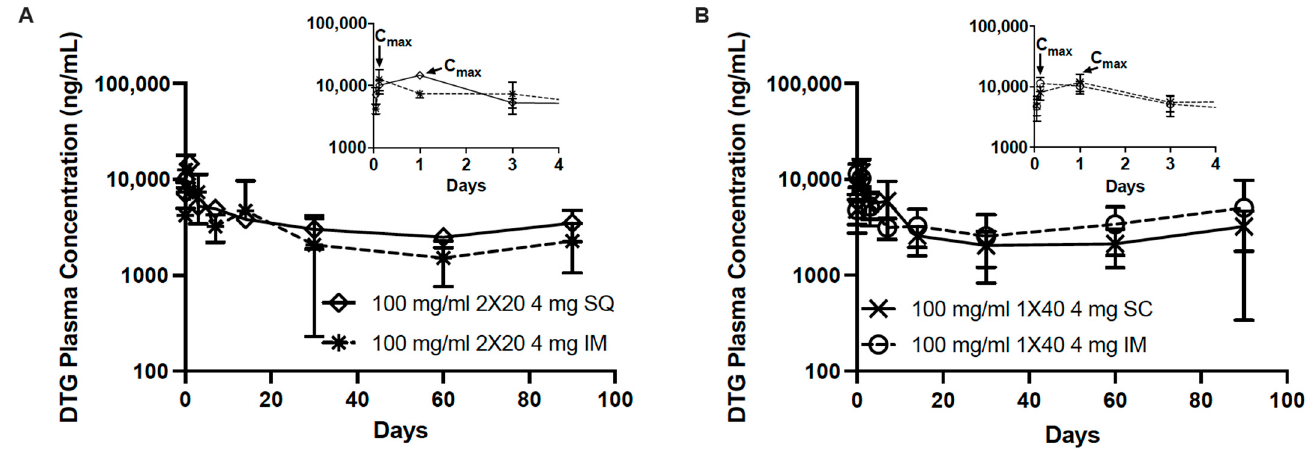
Figure 6. Comparing PK of 100 mg/mL DTG SQ and IM ISFIs with inlay graph through day 4 ( A ) 2 × 20 µ L; 4 mg total dose ( B ) 1 × 40 µ L; 4 mg total Table 1. Pharmacokinetic Non-compartmental Analysis.